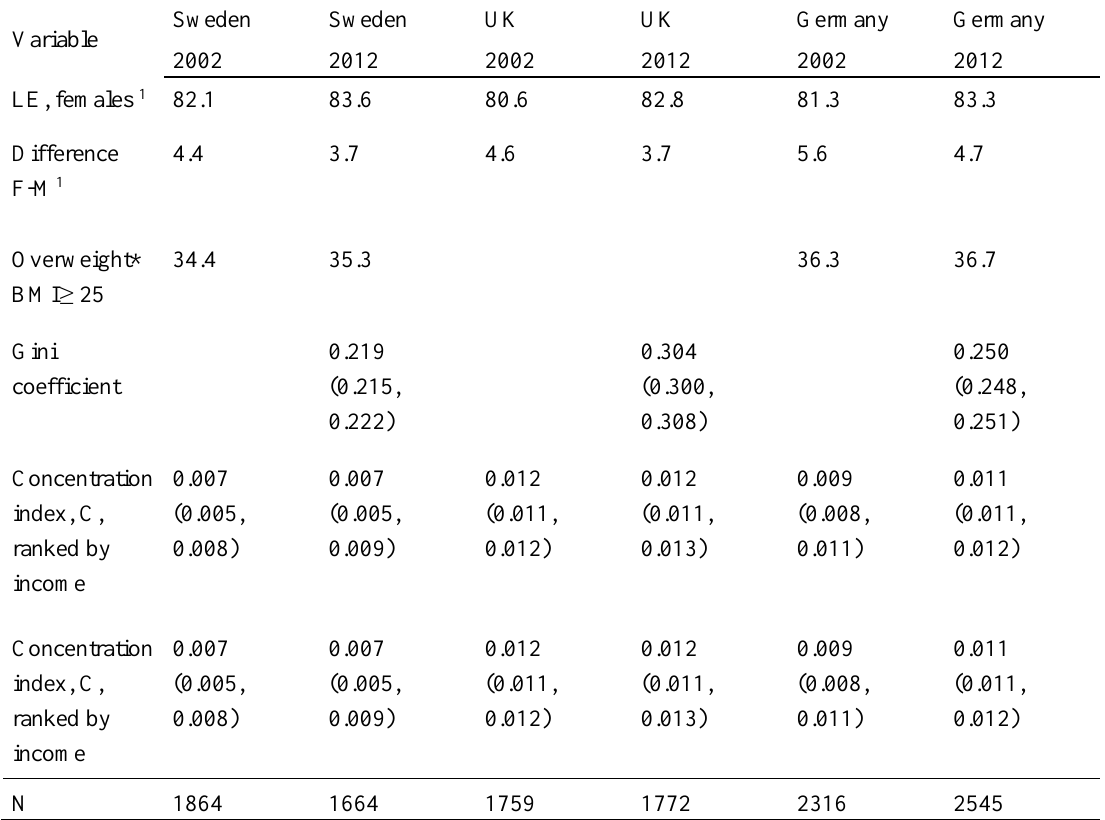
Table 3: Life expectancy, overweight and concentration indices, Nordic countries, UK and Germany 2002 and 2012. Gini coefficients 2012 (continued)